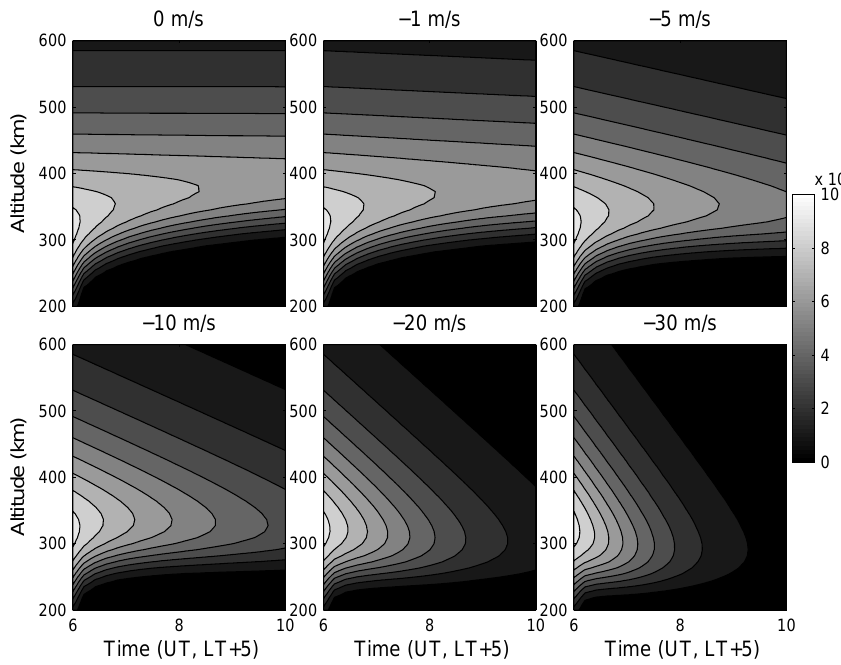
Fig. 8. Contour plots of the electron density for the different values of a constant downward